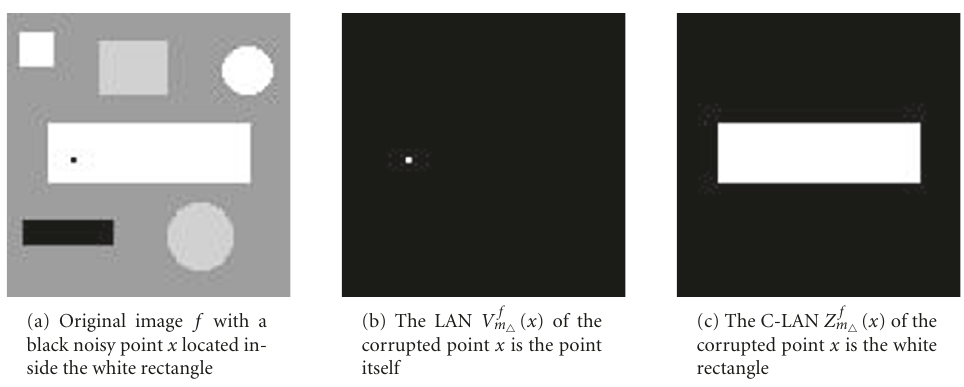
Figure 7: Image (a) contains a black point x (gray-tone 0) inside the white rectangle (gray-tone 255). The point x visually appears as ( x ) of the noisy point x is the point itself (b), while its C-LAN corrupted by an impulse noise. For m < 255 and π t 2 > 1, the LAN V f m (cid:4) (cid:0) (cid:3) ( x ) is the whole rectangle (c). In this way, adaptive median filtering in presence of impulsive noise should be more accurate using the Z f m (cid:3) C-LANs.